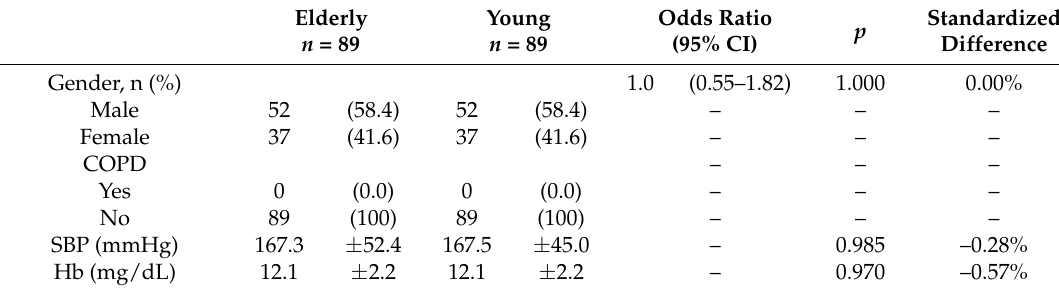
Table 6. Comparison of GCS score and motor response components in the selected propensity–score matched cohort of elderly and young adult patients with head AIS of